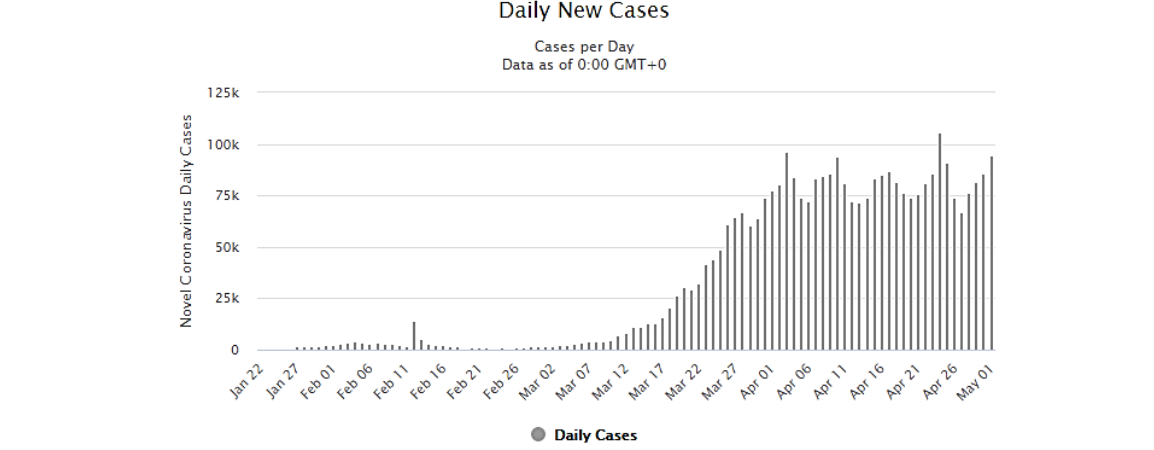
Figure 2. New daily cumulative COVID-19 cases in Italy. Note that Italy's mask use policy for the public was introduced by late March and